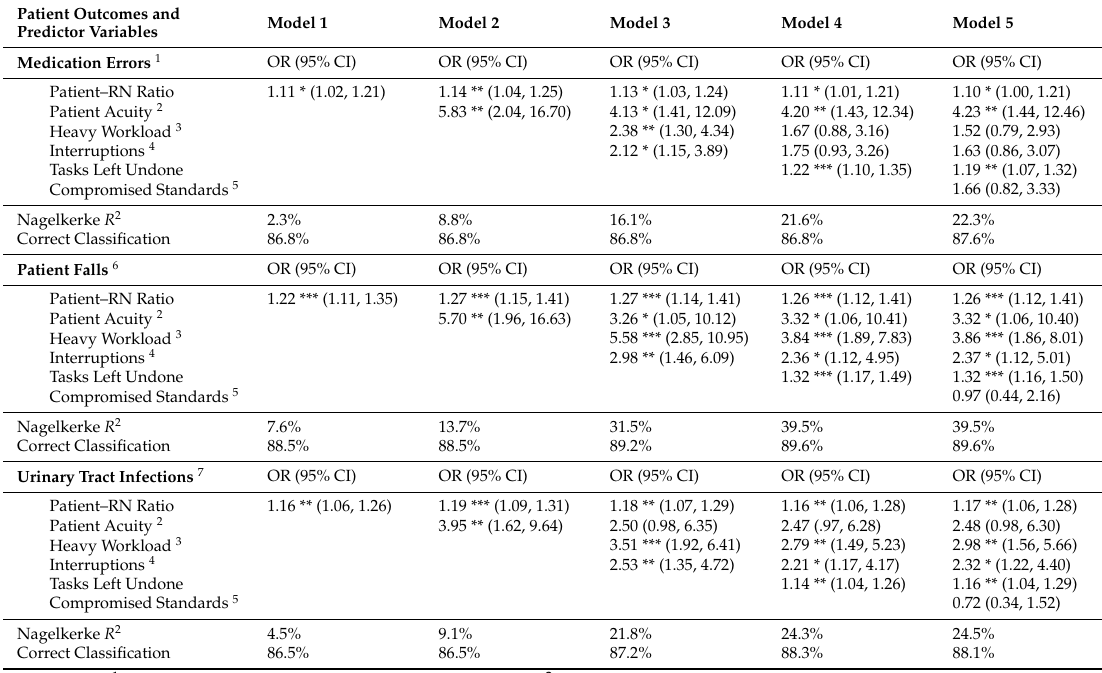
Table 4. Results of hierarchical logistic regression analyses for three patient